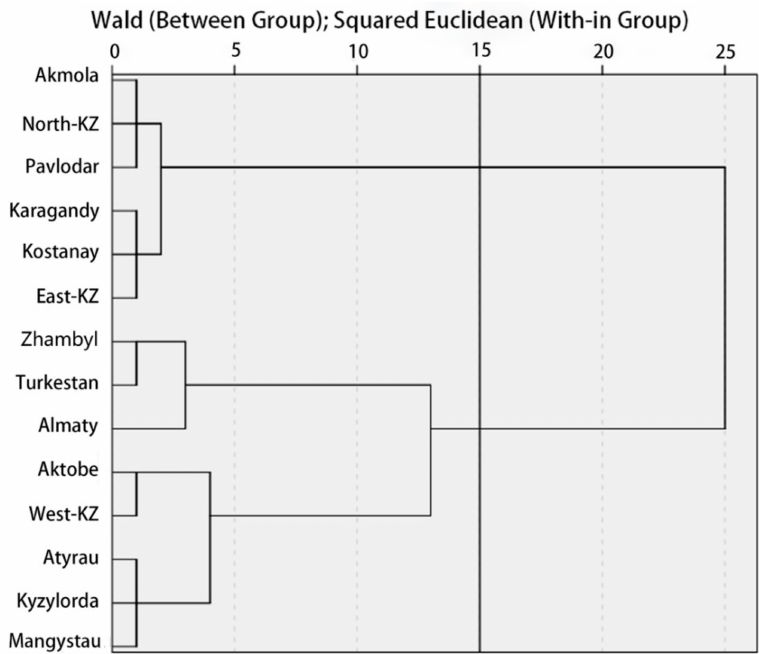
Figure 5. Clustering partitions by climatic